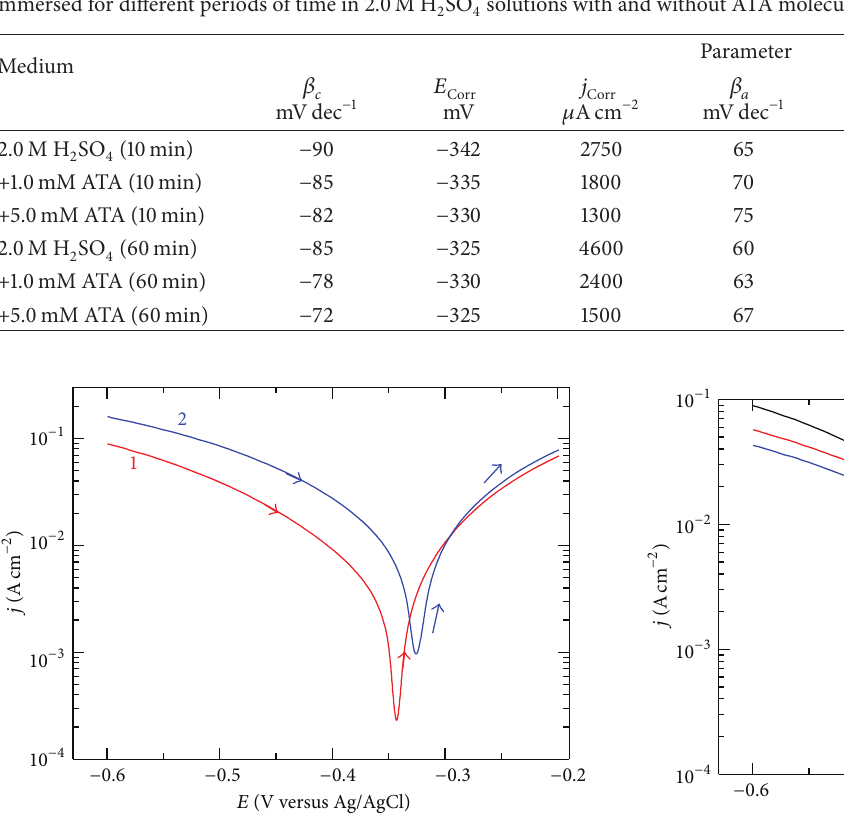
Figure 7: Potentiodynamic polarization curves obtained for the HSLA steel after its immersion for (1) 10min and (2) 60 min in 2.0 M H 2 SO 4 solutions.